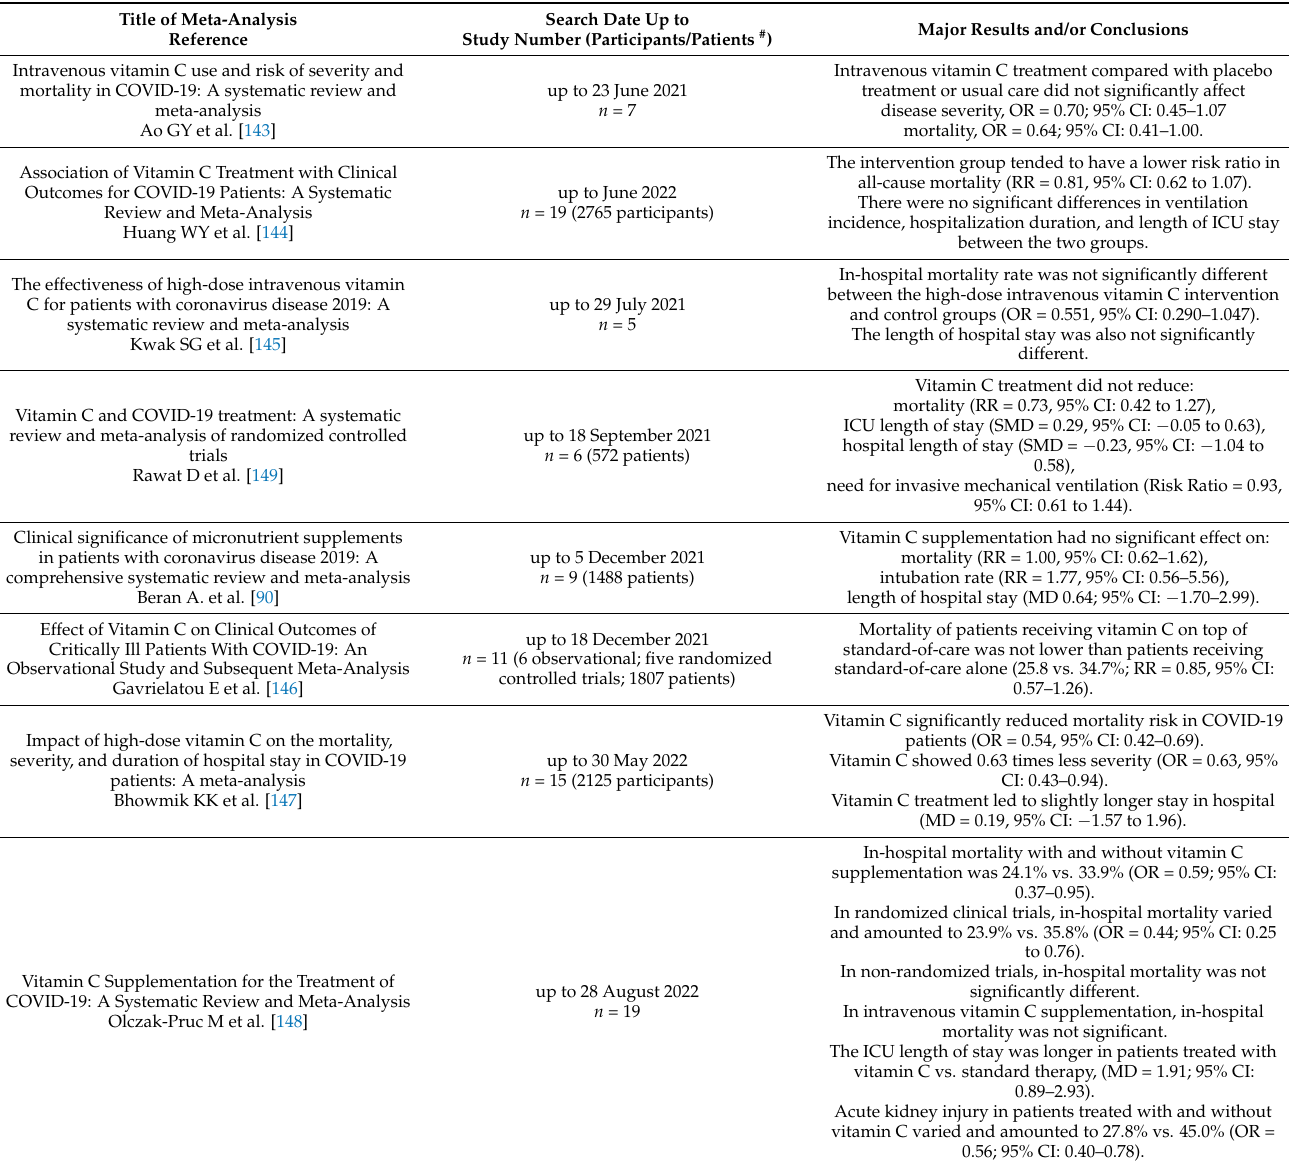
Table 2. Vitamin C and COVID-19: Brief summary of selected meta-analyses of trials studying the effect of vitamin C treatment on clinical outcomes in COVID-19 patients